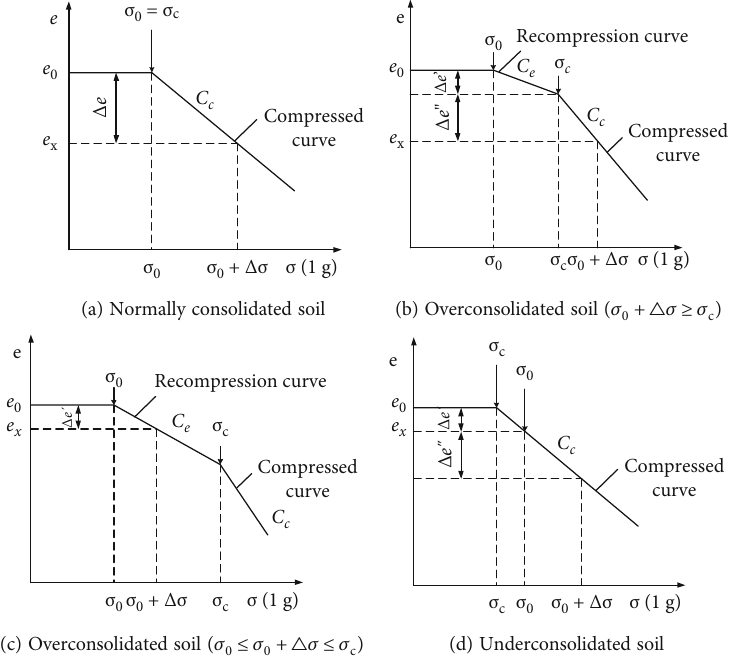
Figure 1: The e − lg σ curves of soil under three consolidation